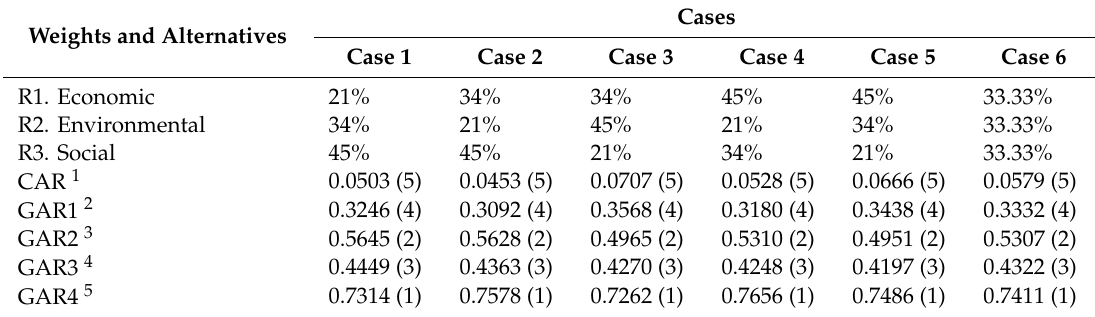
Table 12. Sustainability indices ( SIs ) derived from the sensitivity